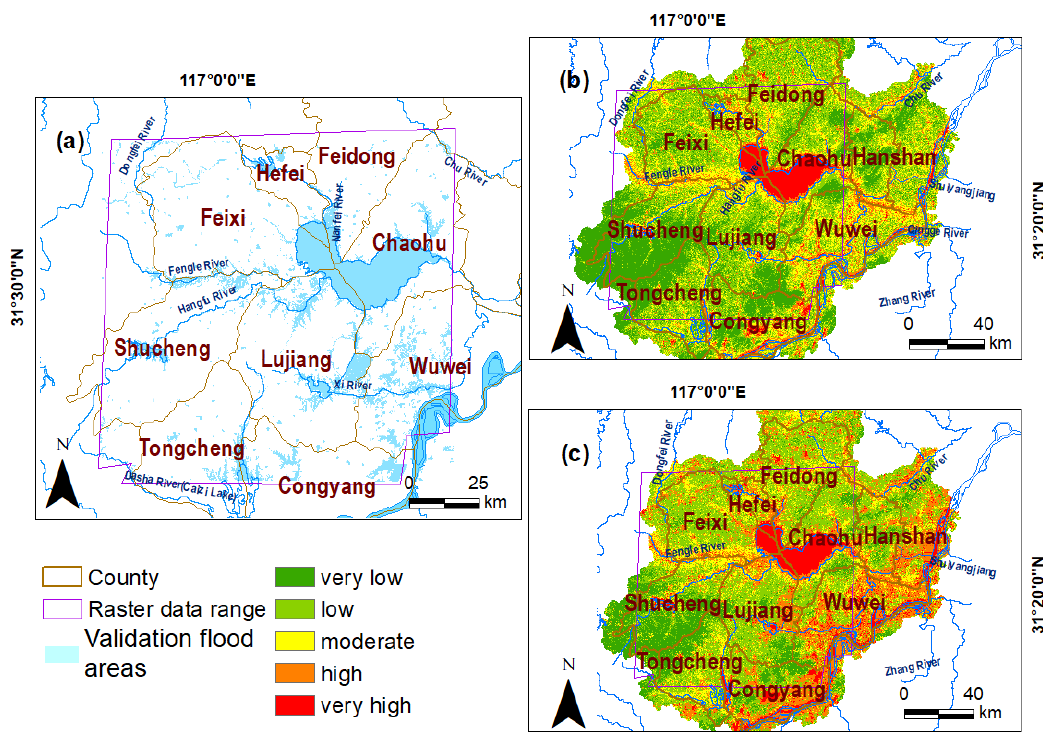
Figure 6. Differences in ground-truthing flooded areas compared with expected flooded areas from the AHP and the proposed model. ( a ) was the distribution of validation flood area, ( b ) was from the original pixel-based AHP, while ( c ) was from the proposed model.